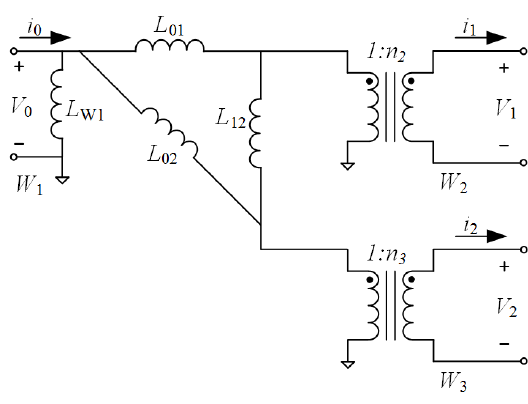
Figure 3. Extended cantilever model for the three windings coupled transformer.